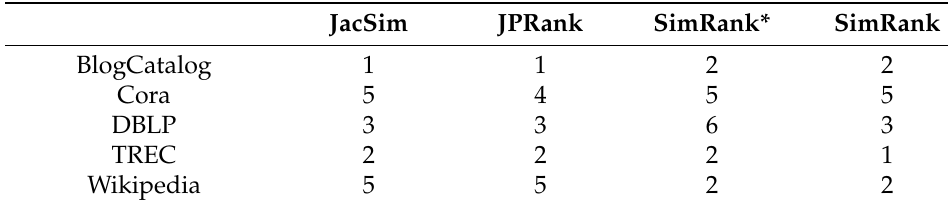
Table 2. Best iterations of all similarity